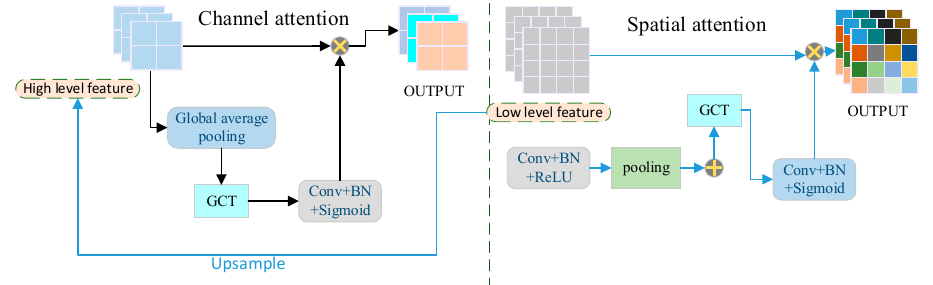
Figure 6. The improved bilateral attention module .